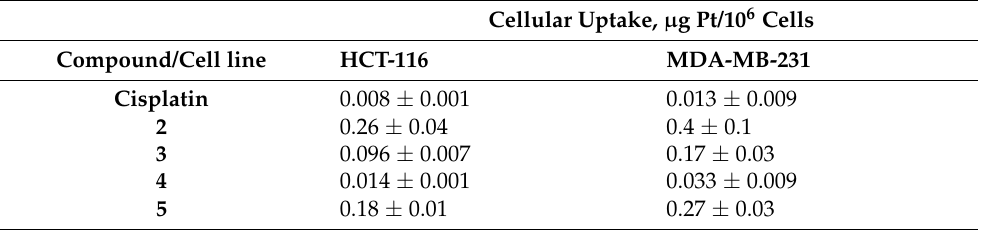
Table 5. Cellular accumulation of prodrugs 2–5 and cisplatin ( µ g Pt/10 6 cells) on HCT-116 (colorectal carcinoma) and MDA-MB-231 (triple negative adenocarcinoma) cell